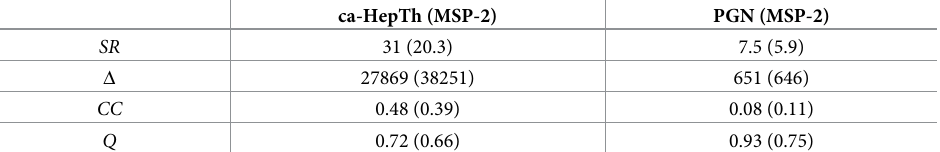
Table 1. Structural and spectral properties of real-world networks and corresponding synthetic networks obtained under our proposed model. Values in brackets represent proposed model properties.